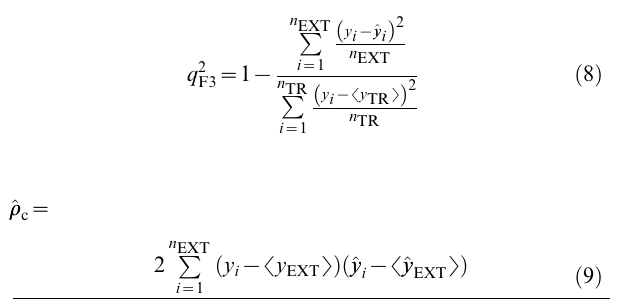
, q 2 , F1 F2 ), maximum c